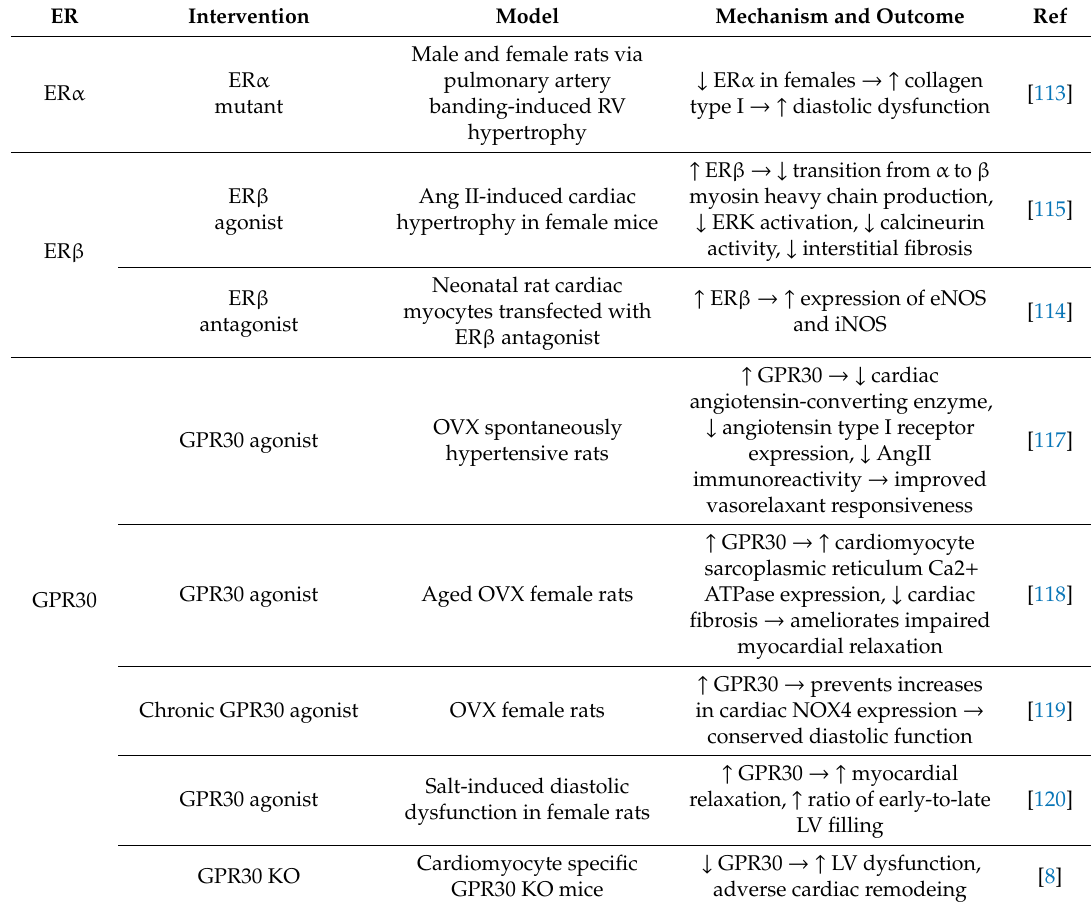
Table 6. Role of estrogen receptors in heart failure with preserved ejection